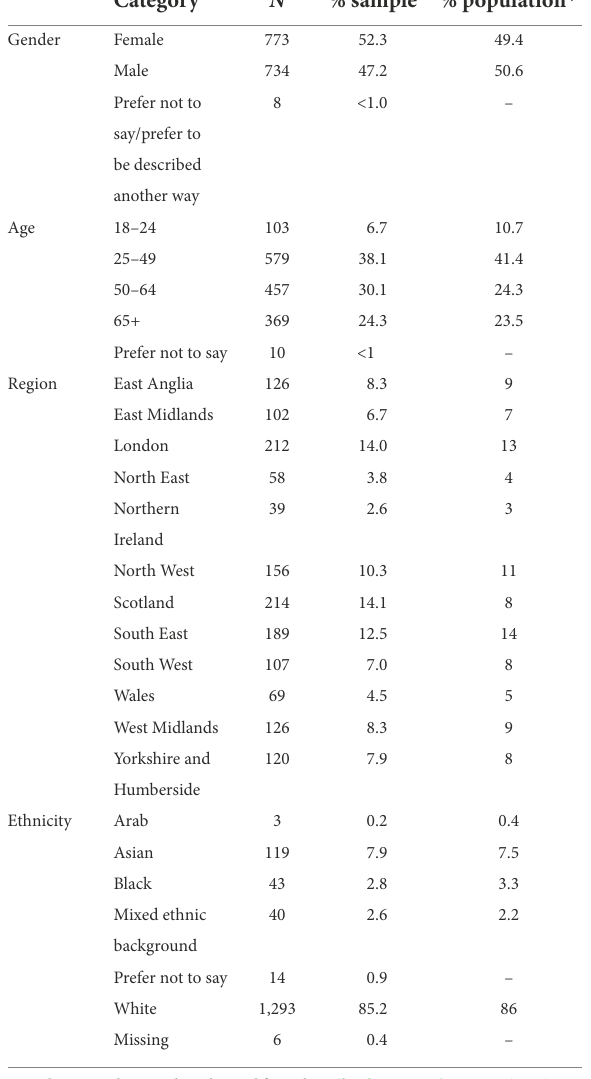
* Gender, age and region data obtained from the Office for National Statistics (2019). Ethnicity data obtained from the (2020). Age percentages are scaled based on the over 18 population. Population statistics for non-binary gender